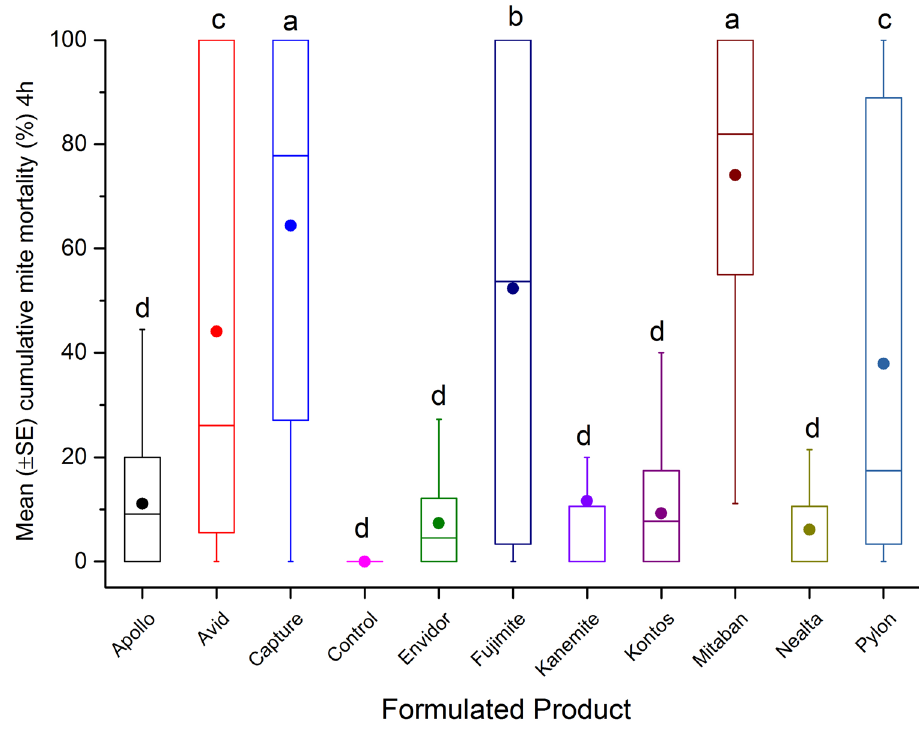
Figure 3. Mean (± SE) cumulative mite mortality (%) during 4 h exposure to different dilutions (0.1 mgL −1 , 1 mgL −1 , 10 mgL −1 , 100 mgL −1 , 1000 mgL −1 , or 10,000 mgL −1 ) of tested FPs in acute surface contact toxicity assay using 20 mL borosilicate glass scintillation vials. A group of mites was treated with different dilutions of Mitaban as reference control, or left untreated (control) as negative control. The boxplots present the standard error (length of box), mean (solid circle), median (horizontal line), 5th and 95th percentiles (lower and upper vertical lines). Each box indicates average mortality for replications of each FP (n = 24) or control (n = 4). Means with the same letter among treatments are not significantly different ( p >